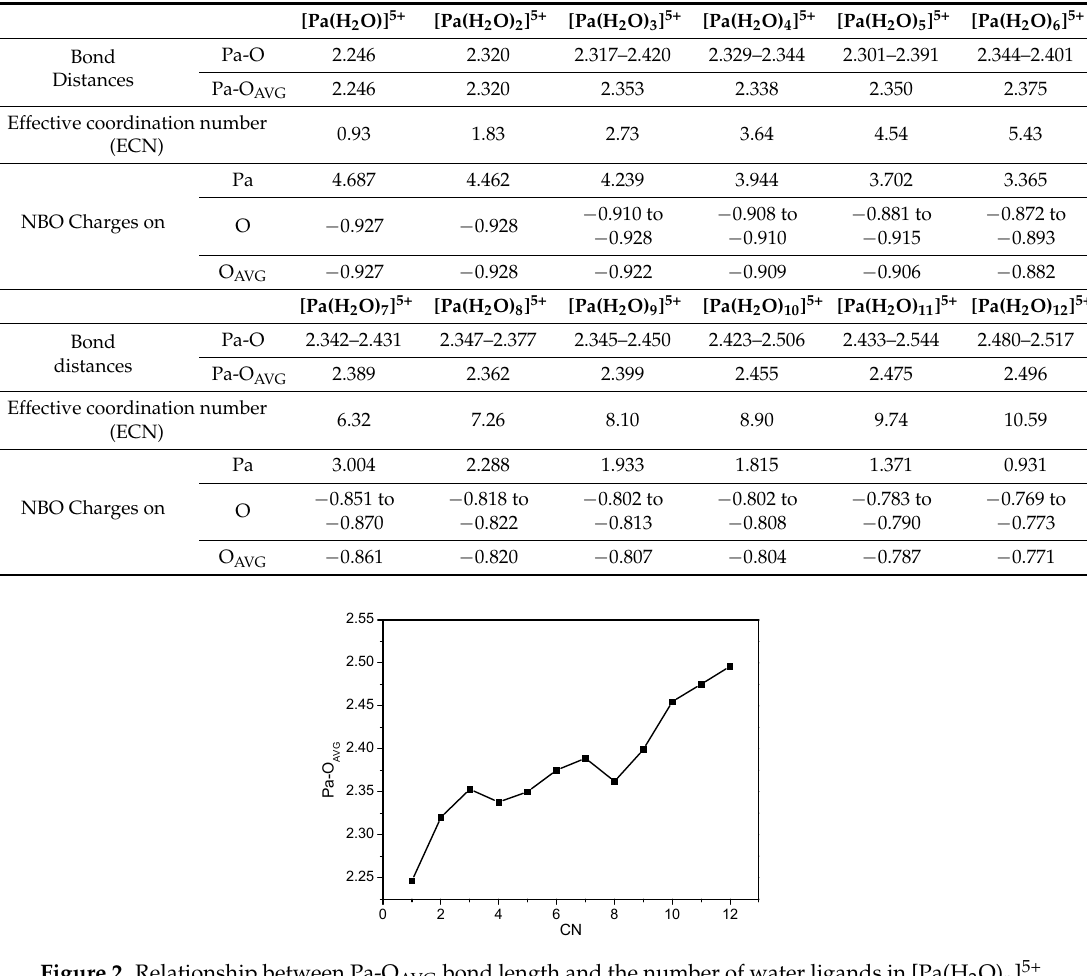
Figure 2. Relationship between Pa-O AVG bond length and the number of water ligands in [Pa(H 2 O) n ] 5+ (n = 1–12). The bond distances were read from the B3LYP/GEN/IEF-PCM method optimized geometries (for details see Figure 1 caption).